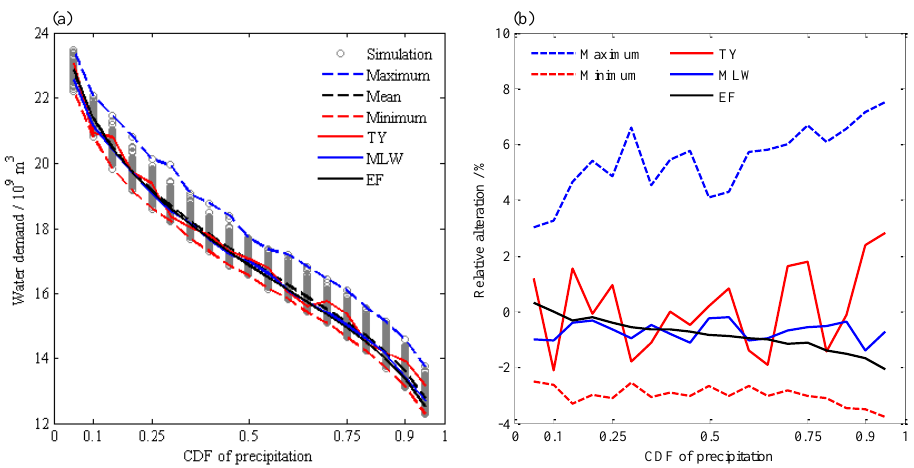
Figure 11. (a) Design water demand of irrigation of the entire region and (b) their relative alteration compared to the average demand.